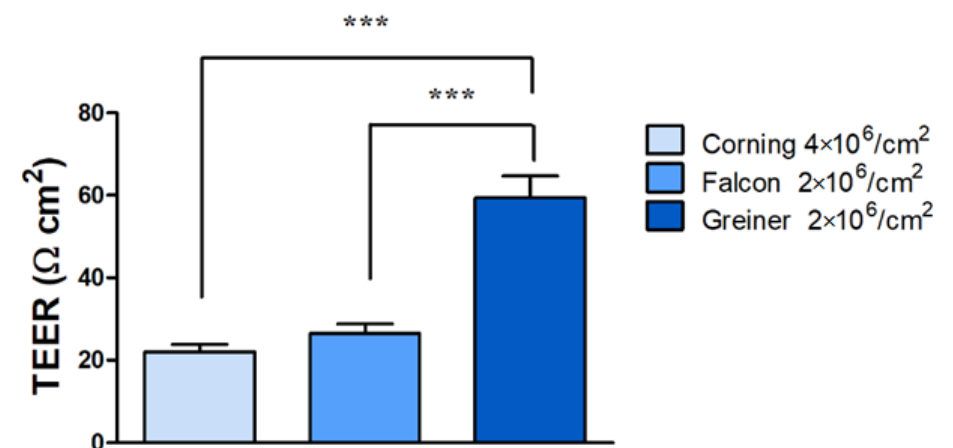
Figure 8. Influence of membrane porosity of culture inserts on the measured transepithelial electrical resistivity (TEER). The TR146 human epithelial cell line was cultured for 2 weeks on polyethylene therephthalate (PET) cell culture inserts from different manufacturers with 2 × 10 6 or 4 × 10 6 pores/cm 2 in 24-well format. Means ± SEM, n = 3, one-way ANOVA and Bonferroni test; *** p < 0.001.